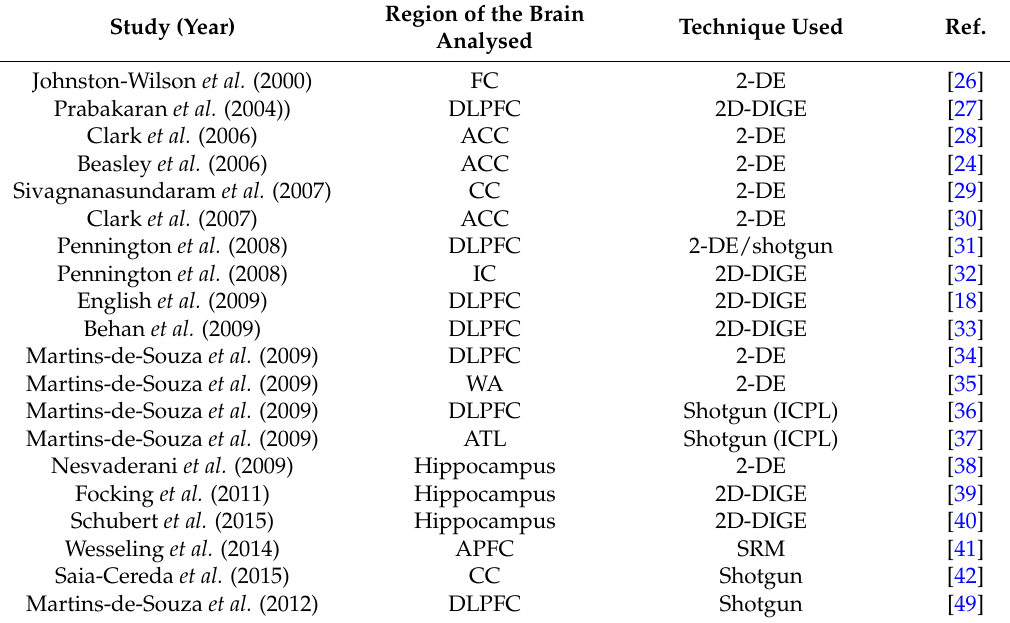
Table 4. Proteomic reports in various tissues from schizophrenia, major depressive disorder and